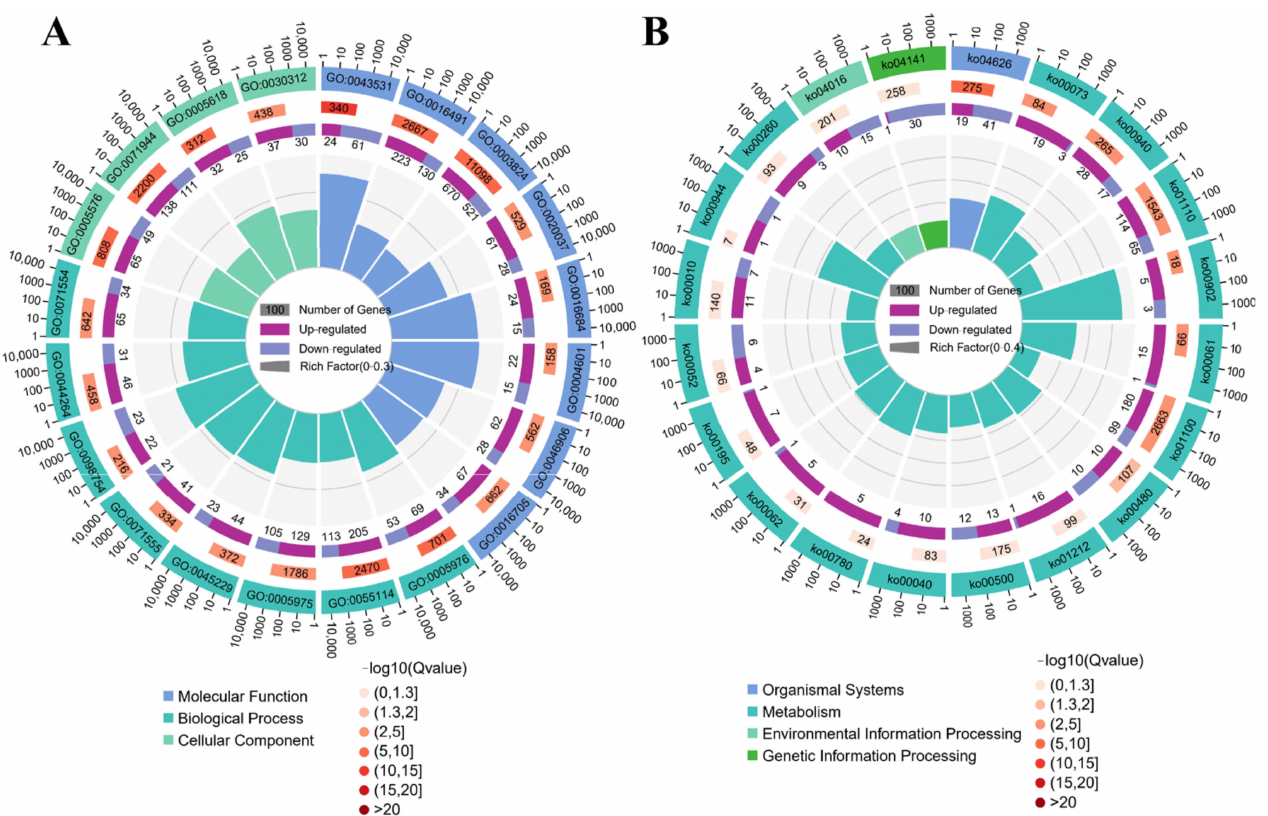
Figure 2. DEG enrichment analysis utilizing GO and KEGG pathways. ( A ) GO classifications of DEGs. ( B ) KEGG classifications of DEGs. The first circle from outside and inside is the path- way of the top 20 enrichment terms, and the number outside the circle is the gene number scale. The second circle represents the number and Q value of the pathway in the background gene. The third circle represents the number and ratio of up- (light purple) and down-regulated (dark purple) genes. The fourth circle represents the Rich Factor value of each pathway.